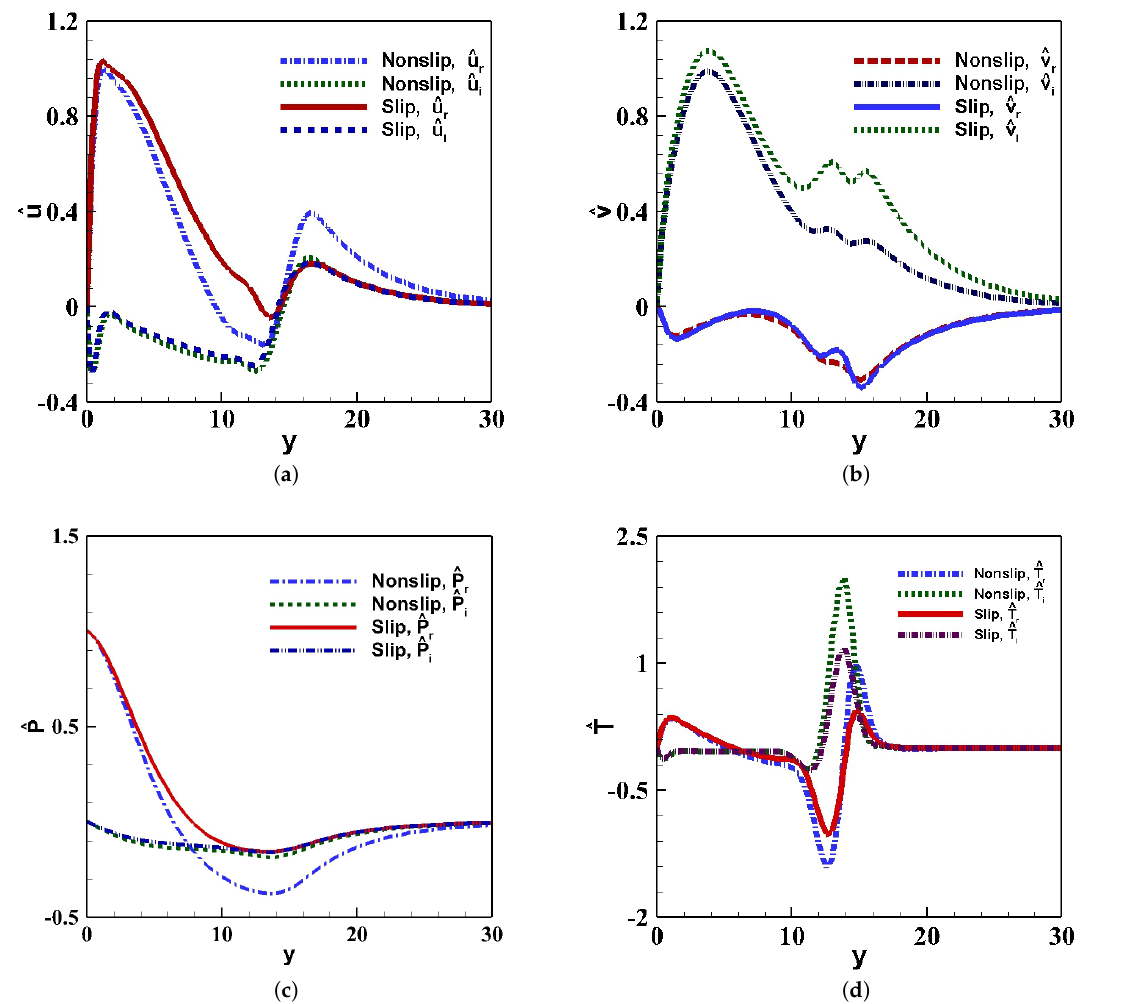
Figure 6. Mode No. 2 (second Mack Mode) related perturbation eigenvectors. Ma e = 4.5, x = 0.139 m, and R = 1000.152. ( a ) ˆ u ; ( b ) ˆ v ; ( c ) ˆ p ; ( d ) ˆ T